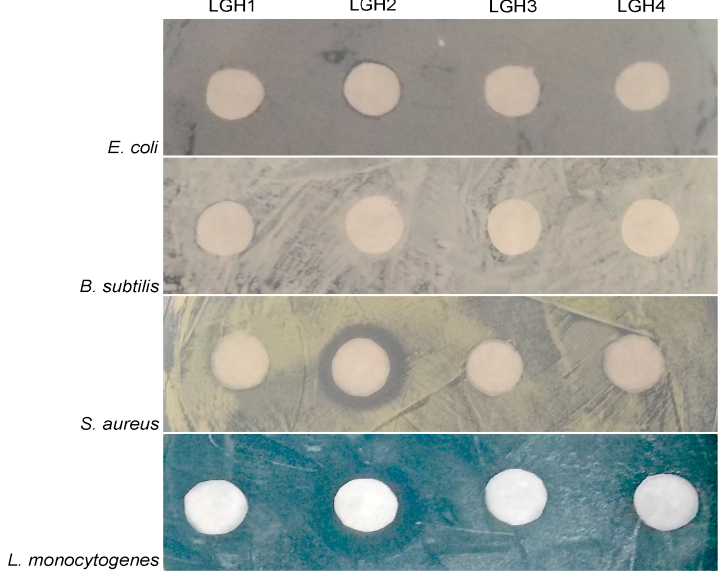
Figure 1. Antimicrobial test of four AMPs. The test operated at 128 μ M. The four tested bacterial strains were E. aerogenes ATCC 13048, L. monocytogenes ATCC 7611, S. aureus ATCC 29213, and B. subtilis BL (collected by our lab).